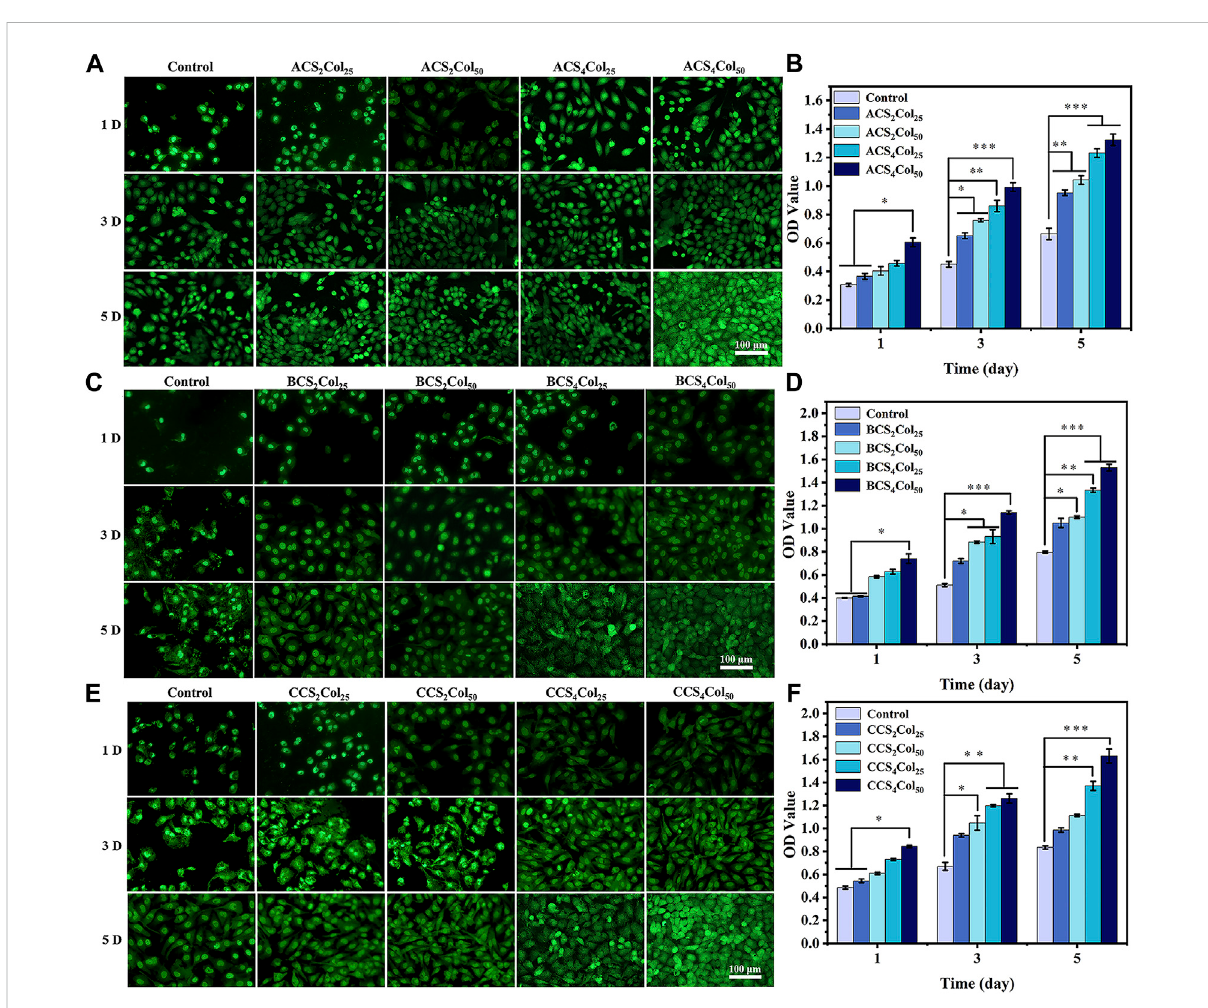
FIGURE 5 AO/EB staining (A,C,E) and cell proliferationactivity (B,D,F) of thecells on thescaffolds. (* p < 0.05, ** p < 0.01, *** p < 0.001) (changedthe fi gure of BCS2Col50,